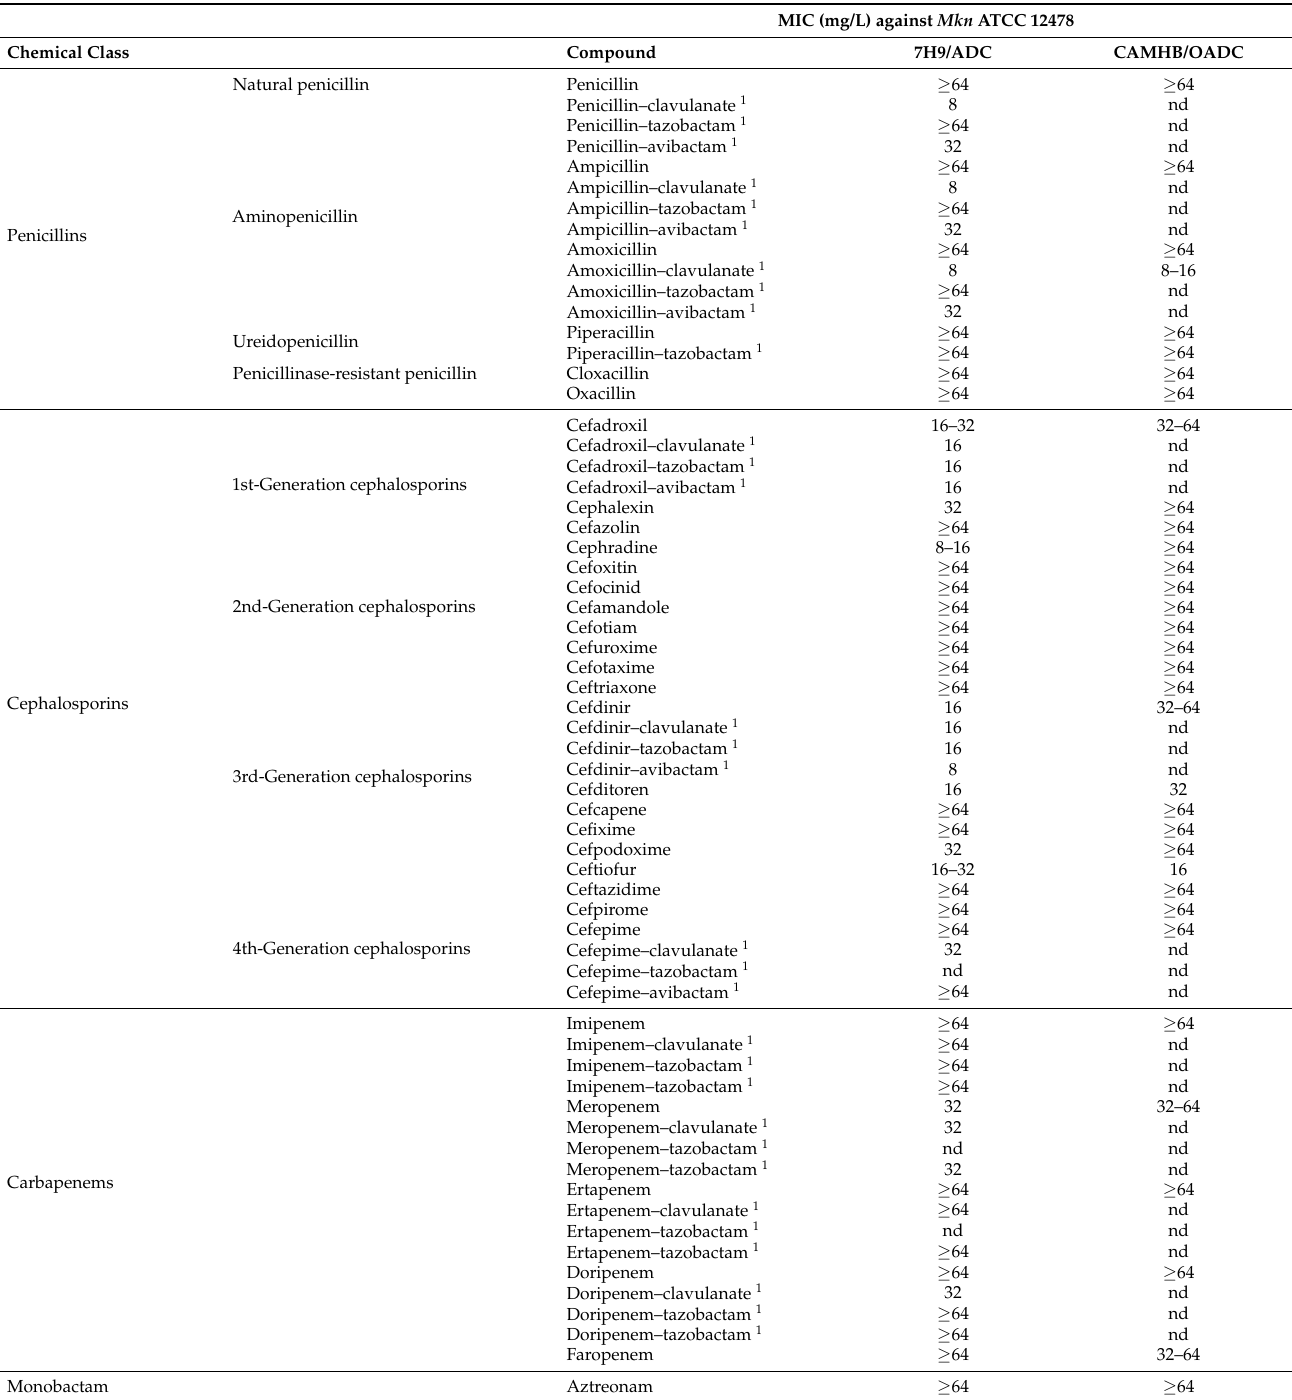
Table 1. MIC (mg/L) of β -lactams against the Mkn ATCC 12478 strain. Penicillins, cephalosporins, carbapenems and a monobactam in the presence or absence of β -lactamase inhibitors were assayed against the Mkn ATCC 12478 reference strain in Middlebrook 7H9 broth plus ADC and cation adjusted Mueller–Hinton broth plus OADC. 1 β -lactamase inhibitors were tested at a fixed concentration of 4